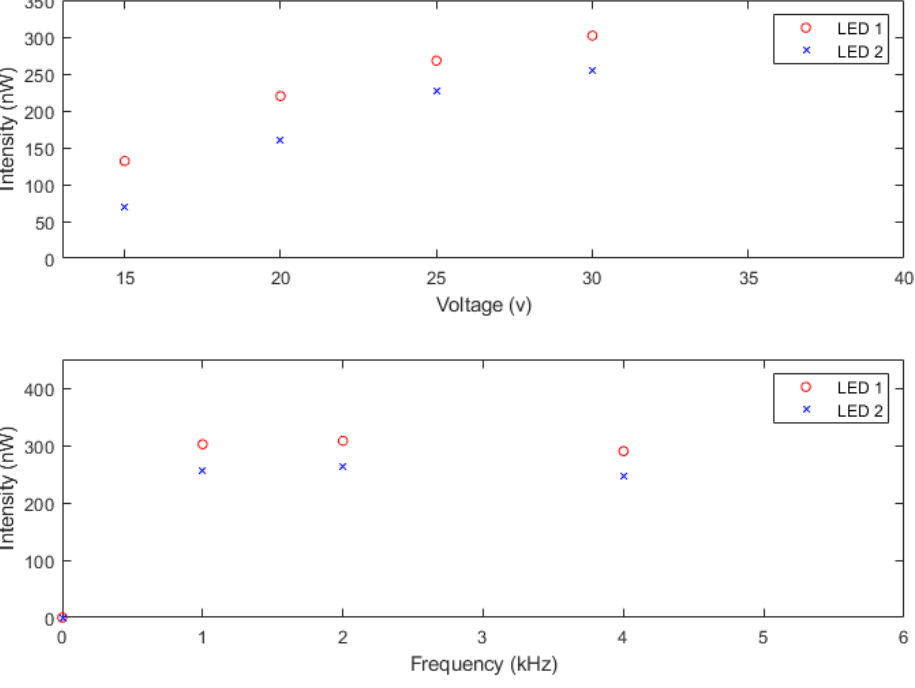
Figure 11. NOPELED pulse intensity measured in two LEDs at different values of voltage with the frequency fixed at 1 kHz ( top ). The pulse intensity has also been measured at different frequencies with the voltage fixed at 30 V ( bottom ). The intensity increases with the voltage and stays stable with